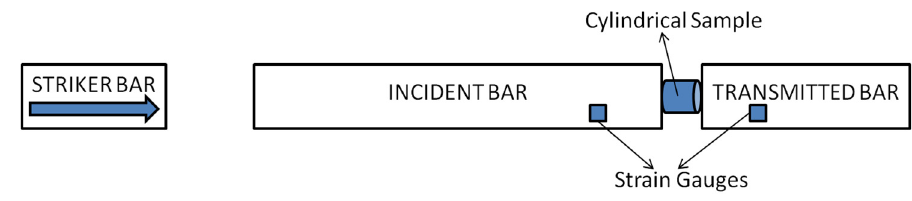
Figure 3. Schematic diagram of SHPB. Table 2. True stress-true strain values given as input to SHPB simulations in present study [41]. For Strain Rate- 2220/s